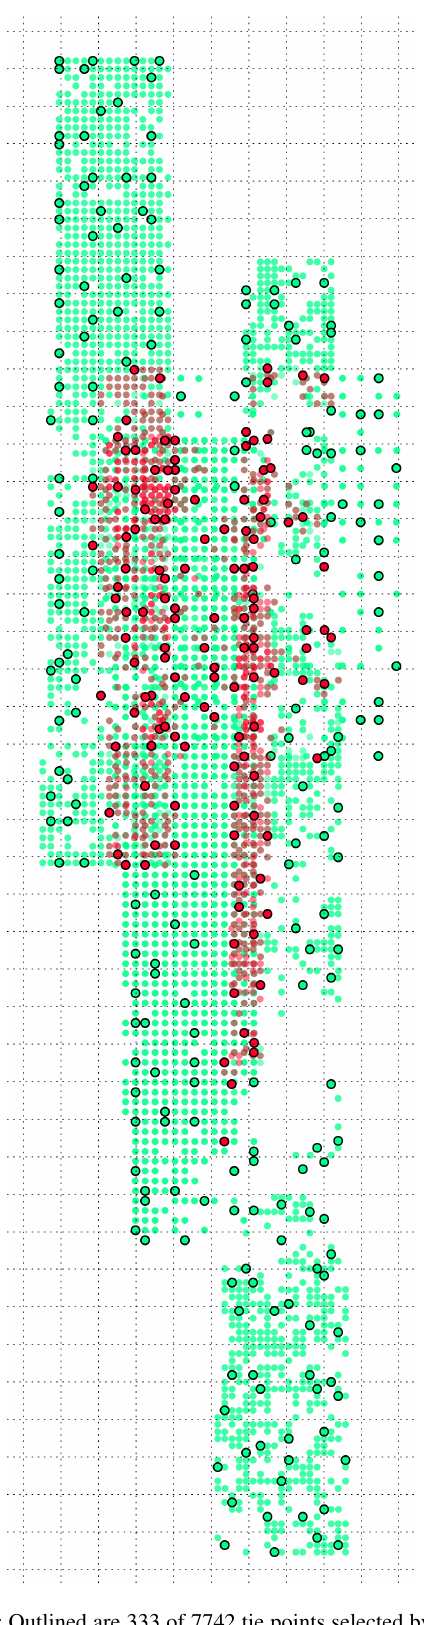
Figure 8: Outlined are 333 of 7742 tie points selected by a filter; in green: single-strip points; in red: multi-strip points; used sub-block option: pairwise; used grid cell size: 64 MEDGR pixel (approx.